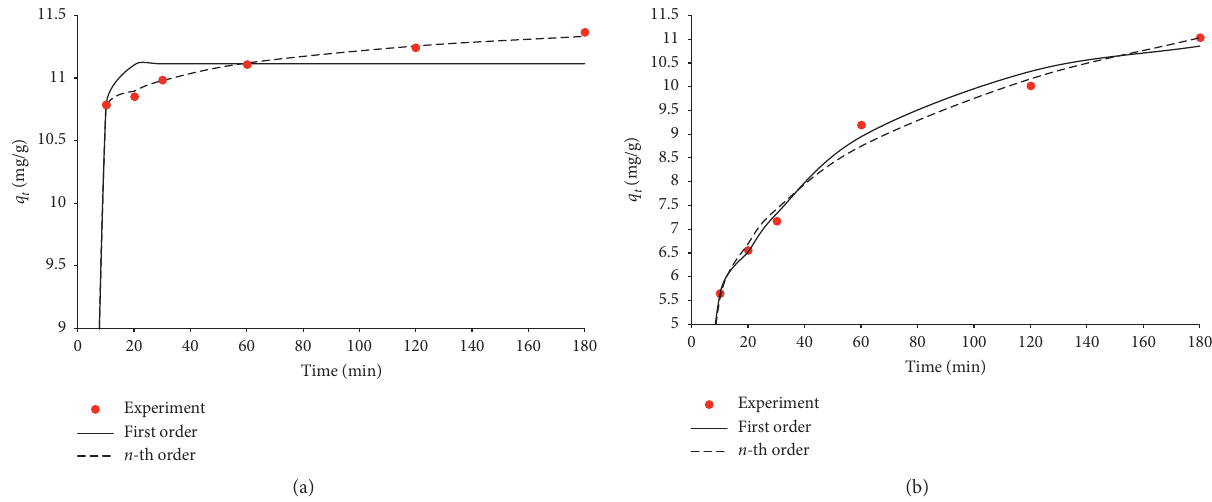
Figure 3: Semianalytical approximation for kinetic model to simulate the sorption kinetic data for initial concentration of (a) 200 and (b) 400mg/L. Table 4: Parameters of different semianalytical models for sorption kinetic data of nickel ions-CKD interaction.